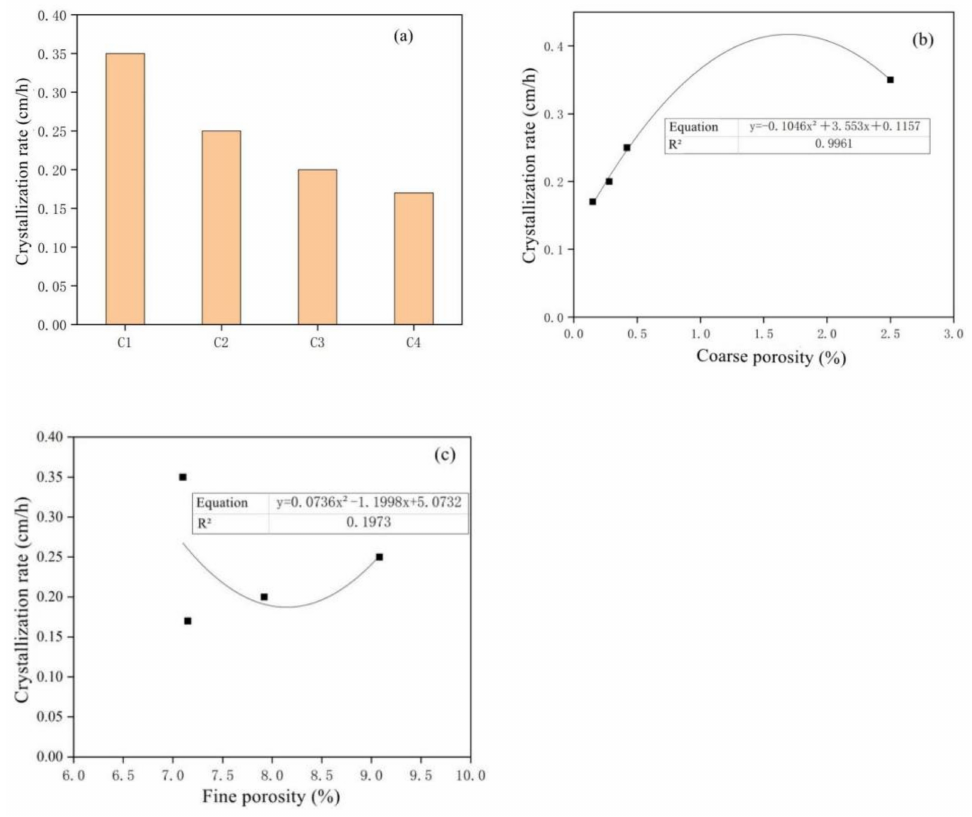
Figure 16. Diagrams of crystallization rate versus MSWI content ( a ), coarse porosity ( b ) and fine porosity ( c